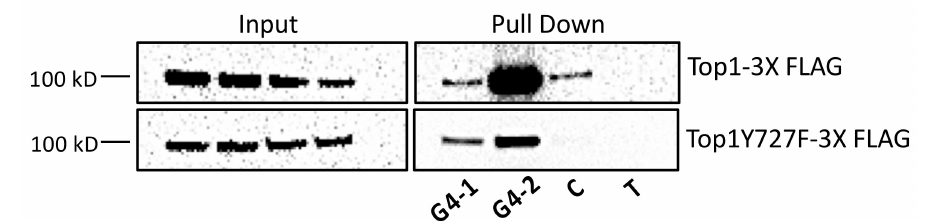
Figure 1. Yeast WT Top1 and Top1Y727F bind to G4 structures. Western blots of pulldowns of WT Top1-3XFLAG (top) and Top1Y727F-3XFLAG (bottom) from yeast whole cell lysates with biotinylated DNA oligonucleotides (MilliporeSigma). Biotinylated oligonucleotides G4-1, G4-2, C, and T were